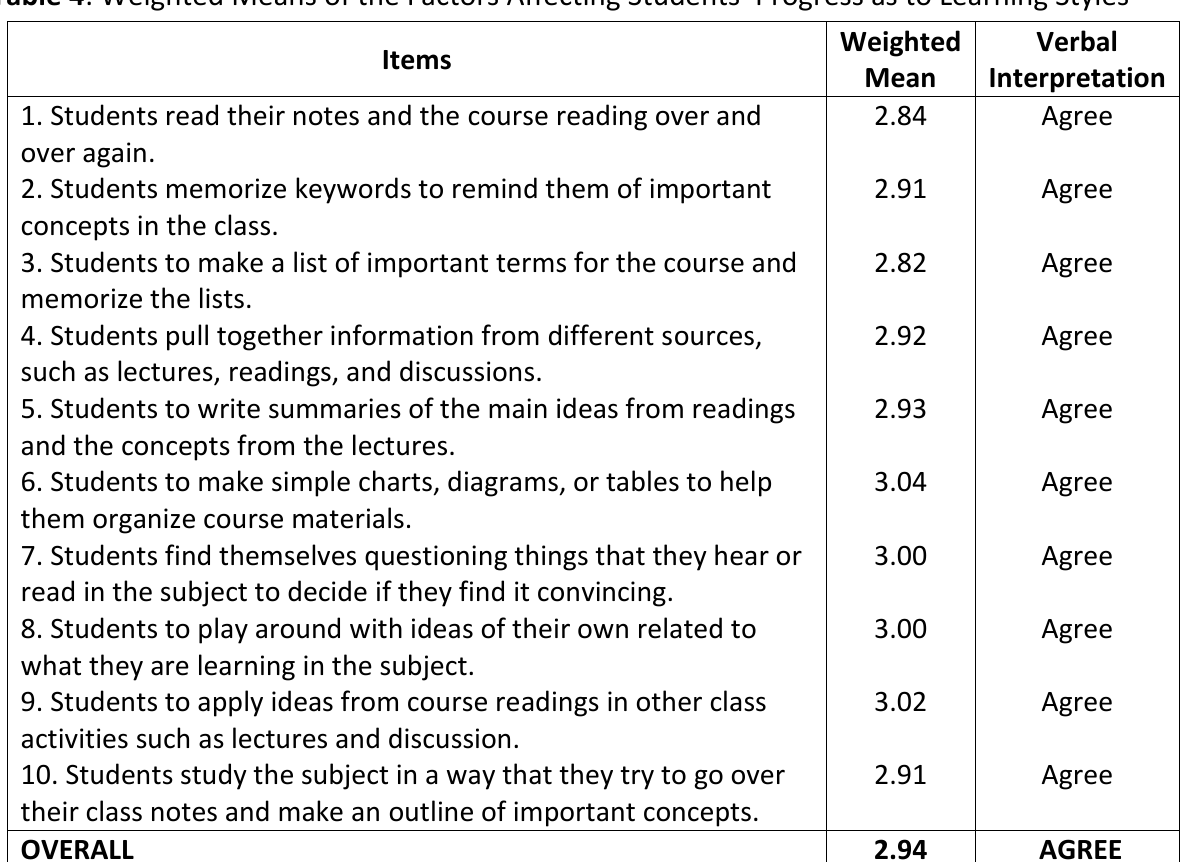
Table 4 : Weighted Means of the Factors Affecting Students’ Progress as to Learning